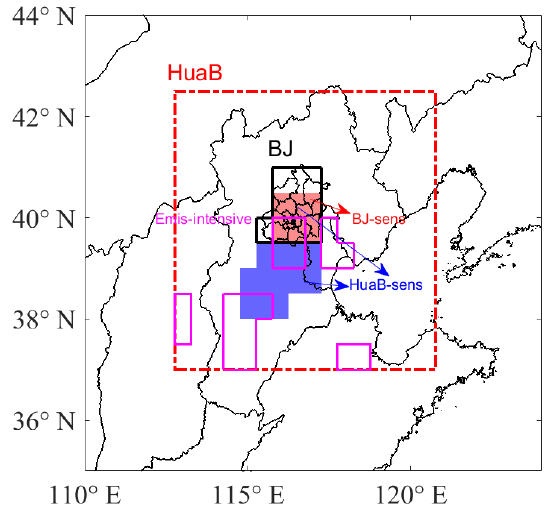
Figure 14. Domain definition of Huabei (HuaB, in red dot-dashed frame), Beijing (BJ, in black solid frame), sensitive Beijing (BJ- sens, red shaded), sensitive Huabei (HuaB-sens, both red and blue shaded), and emission-intensive (Emis-intensive, in pink solid frame)